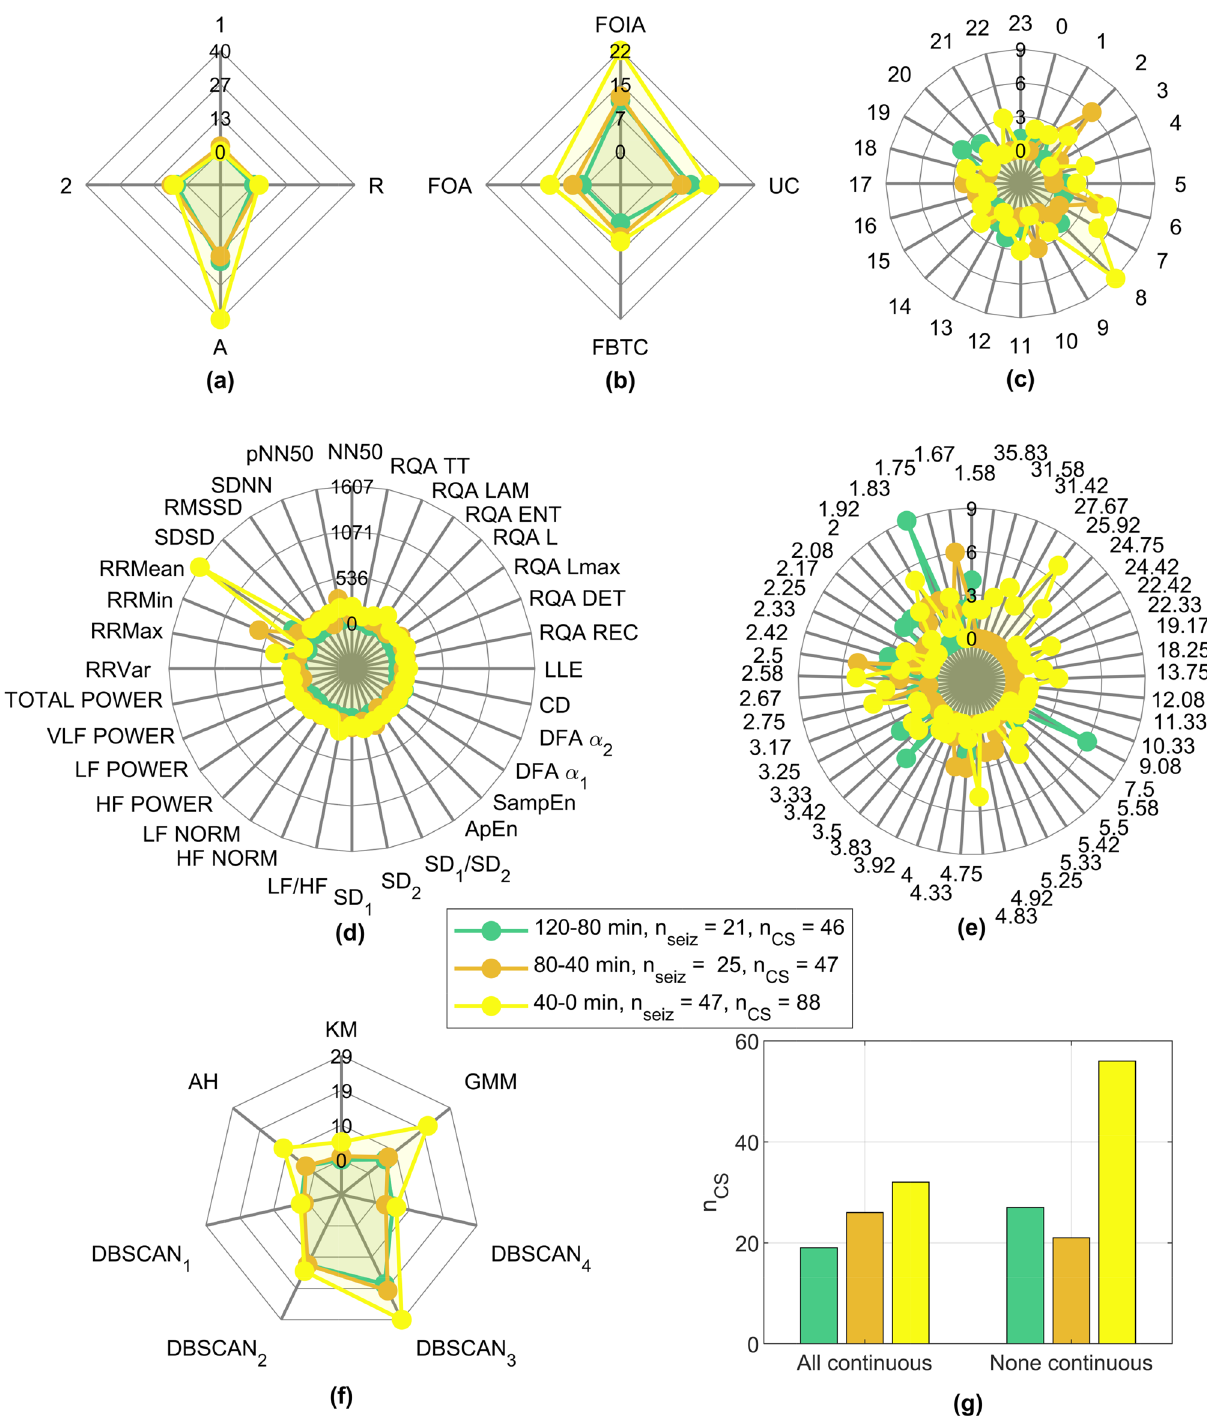
Figure 5. Characterization of the clustering results for each 40-min interval. ( a ) Seizure vigilance state (A: awake, 1: sleep stage I, 2: sleep stage II, R: REM sleep), ( b ) seizure type (FOA: focal onset aware, FOIA: focal onset impaired awareness, FBTC: focal to bilateral tonic-clonic, UC: unclassified), ( c ) seizure onset time, ( d ) most frequent features, ( e ) duration of the smaller cluster (minutes), ( f ) most frequent clustering methods and ( g ) time continuity of the smaller cluster (“All continuous” was assigned when all solutions found for that seizure were continuous and “None continuous” if no solution was continuous). n CS indicates the number of clustering solutions found in each interval, including when more than one solution was found for each